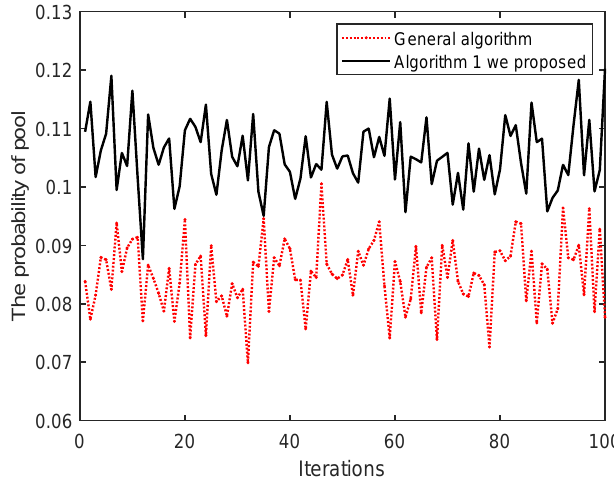
Figure 12. Iterations vs. The probability of pool.